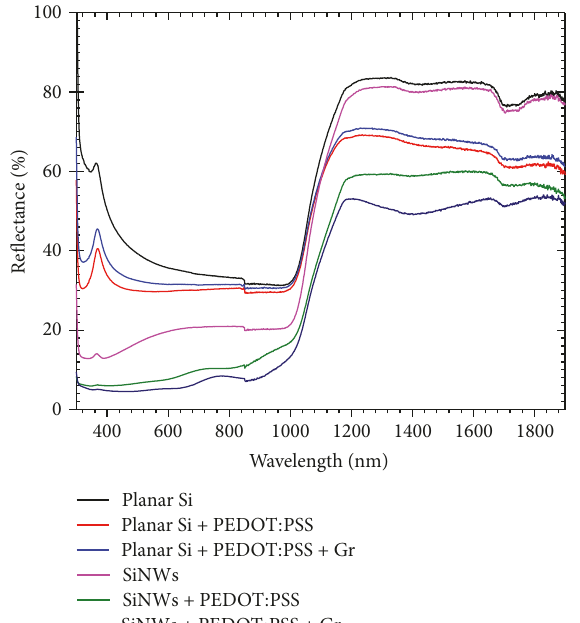
Figure 5: Reflectance spectra of a planar Si wafer, planar Si coated PEDOT:PSS, planar Si coated PEDOT:PSS/Gr, SiNWs, SiNWs coated PEDOT:PSS, and SiNWs coated